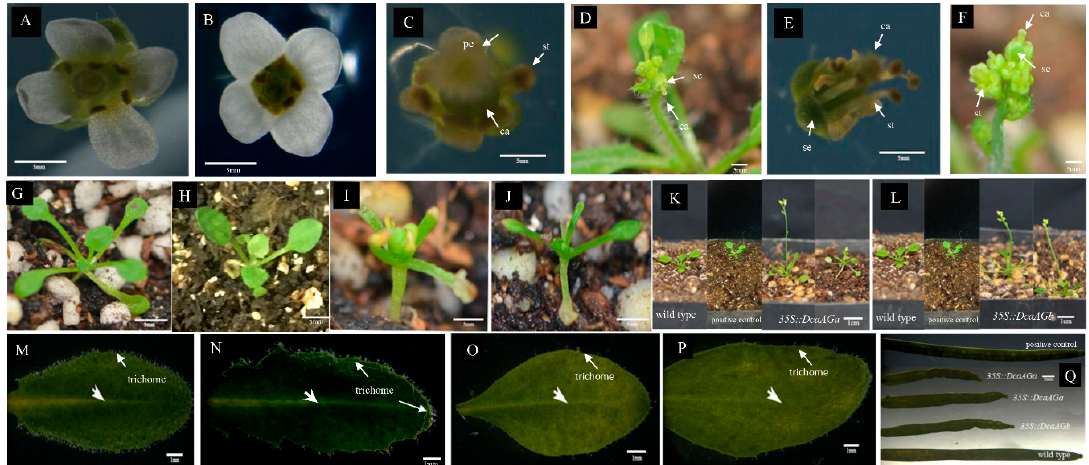
Figure 7. Phenotypic analysis of transgenic plants by overexpressing DcaAG genes in Arabidopsis . The flower of the wild-type Arabidopsis (A) and positive control group ( B ) ( Arabidopsis transformed